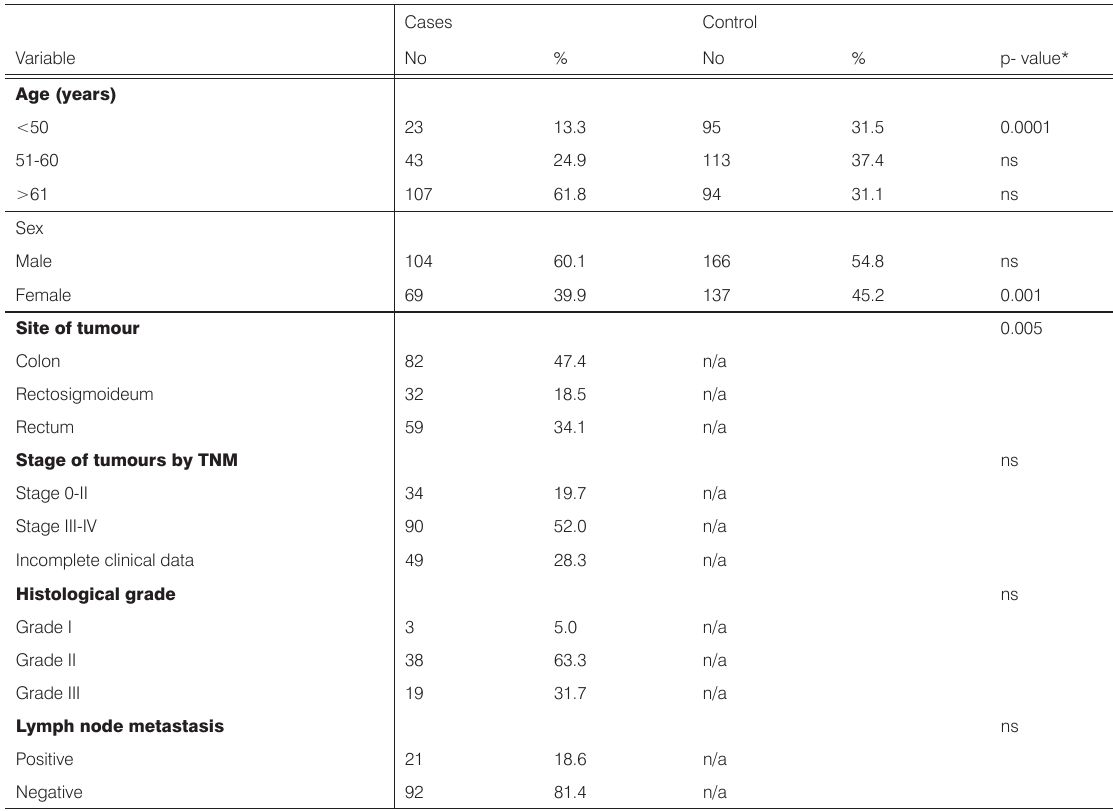
Table 1. Frequency distributions of selected variables in colorectal patients and cancer-free